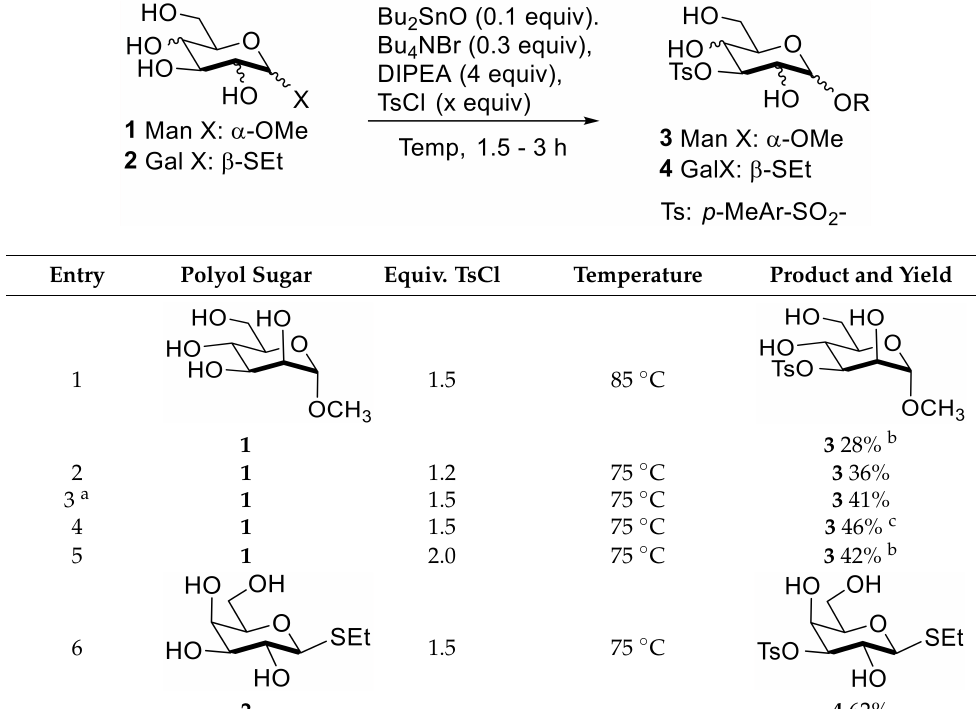
Entry Polyol Sugar Equiv. TsCl Temperature Product and